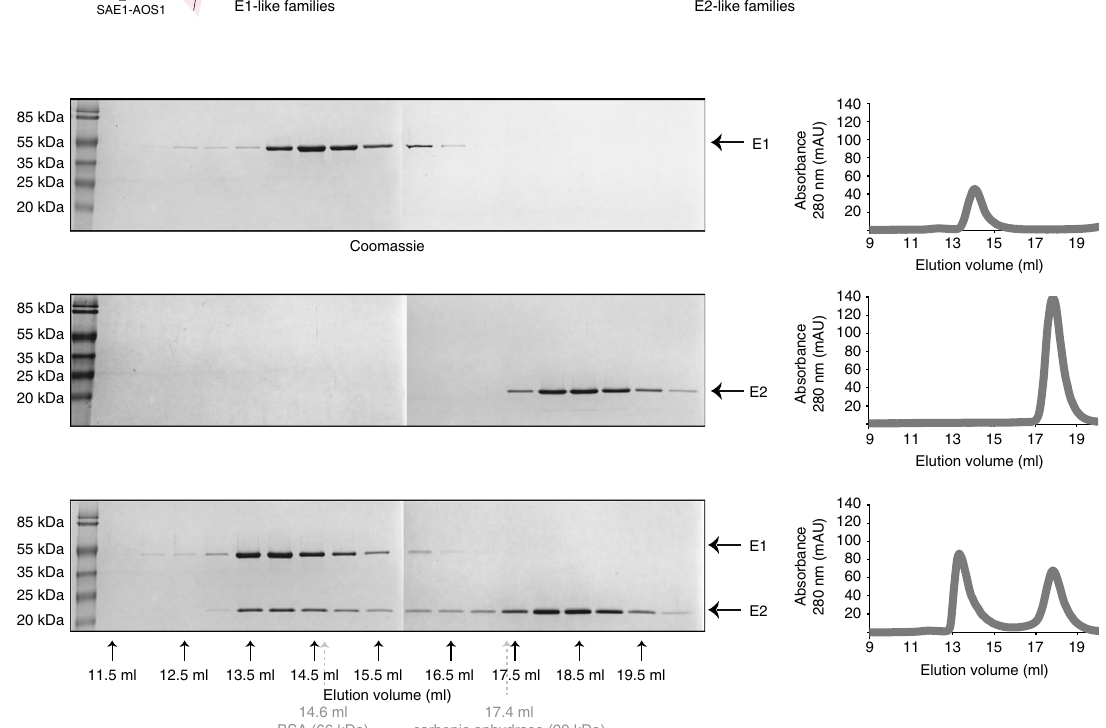
Fig. 4 Phylogenetic comparisons between the archaeal and eukaryotic E1 and E2 homologues and demonstration of the C. subterraneum E1-E2 interaction and complex formation by size exclusion chromatography. a – b Phylogenetic analysis of the E1-like a and E2-like b homologues. Unrooted maximum likelihood trees inferred with iqtree and the LG + R8 a and LG + R6 b models. Ultrafast-bootstrap support values for the deepest nodes are indicated by empty (UFBoot ≥ 95) and fi lled circles (UFBoot ≥ 99). Major clades of the E1 and E2 phylogenies are named according to the nomenclature used by Burrough s et al. 38 and Stewart et al. 18 , respectively. Clades are colour-coded according their taxonomic af fi liation: eukaryotes (red), bacteria (blue), archaea (orange) and mixed (grey). Asterisks denote E2-like homologues described further in Supplementary Fig. 1. Abbreviations: a, Asgard archaea homologues. c Physical interaction between the C. subterraneum E1 and E2 components demonstrated by size exclusion chromatography. left: C . subterraneum E1-like enzyme only (top), E2-like protein only (middle), or pre-incubated E1-like and E2-like proteins (bottom) were separated on a superdex S200 HR 10/300 size exclusion chromatography column. The relative elution volumes of the size standards bovine serum albumin (BSA) (66 kDa) and carbonic anhydrase (29 kDa) are also indicated (in grey). Eluted fractions were resolved by SDS-PAGE and visualised by Coomassie stain. Right: chromatography UV traces (at 280 nm) for the respective elution pro fi